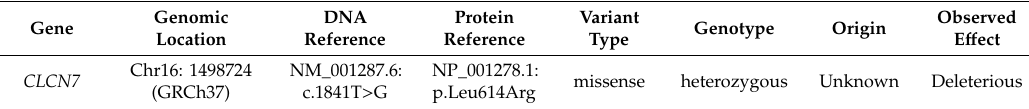
Table 2. Genomic findings newly identified in the proband diagnosed with